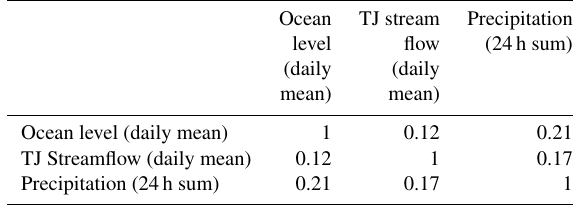
Table A1. Pearson’s correlation coefficient matrix between the three drivers of flooding considered in this study. The numeric values in the table describe the correlation between the variables in the row and column headings. Correlation coefficients were determined us- ing de-trended tide gage data at La Jolla (NOAA station 9410230), precipitation measurements from the San Diego International Air- port (NOAA network ID GHCND:USW00023188), and TJ River streamflow measurements at the US–MX border recorded by the International Boundary and Water